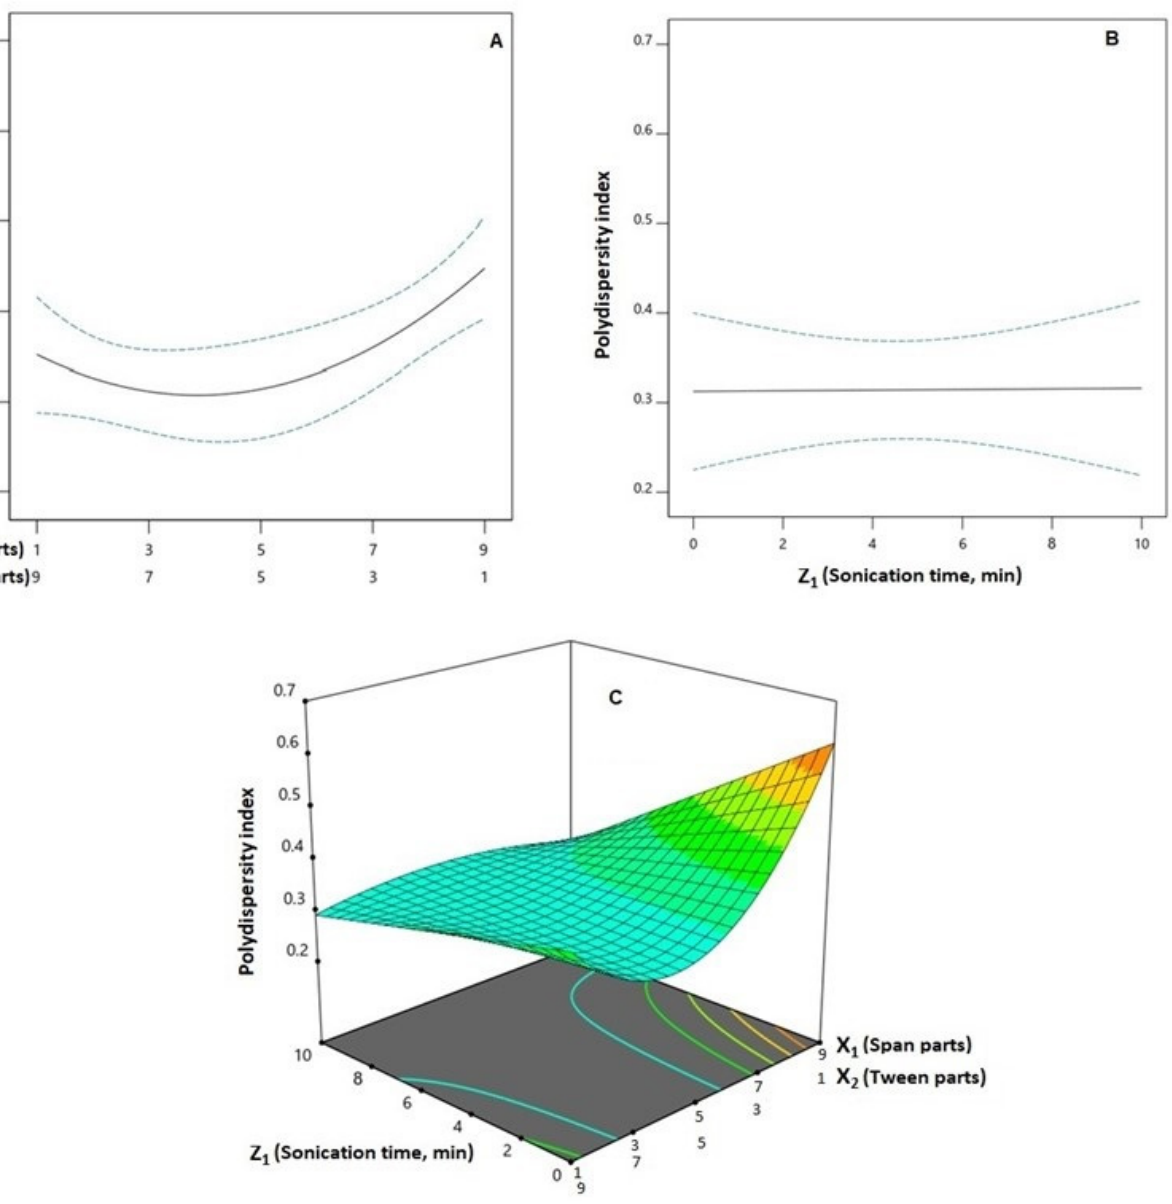
Figure 3. One-factor plots for the effect of the binary mixture components ( A ) and the sonication time ( B ) at the mid-values of the other variables on polydispersity index (Y 2 ); three-dimensional mixture–process plot ( C ) for the interaction between mixture components and sonication time. Abbreviations : SMV, simvastatin; SPNs, spanlastics; X 1 , Span 20 parts; X 2 , Tween 60 parts (X 1 and X 2 add up to 10 parts).